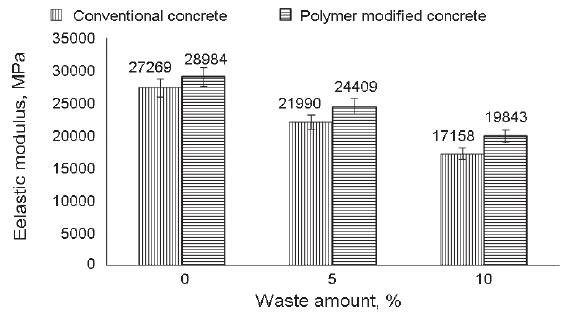
Fig. 7. influence of the amount of ecW on elastic modulus of concrete samples